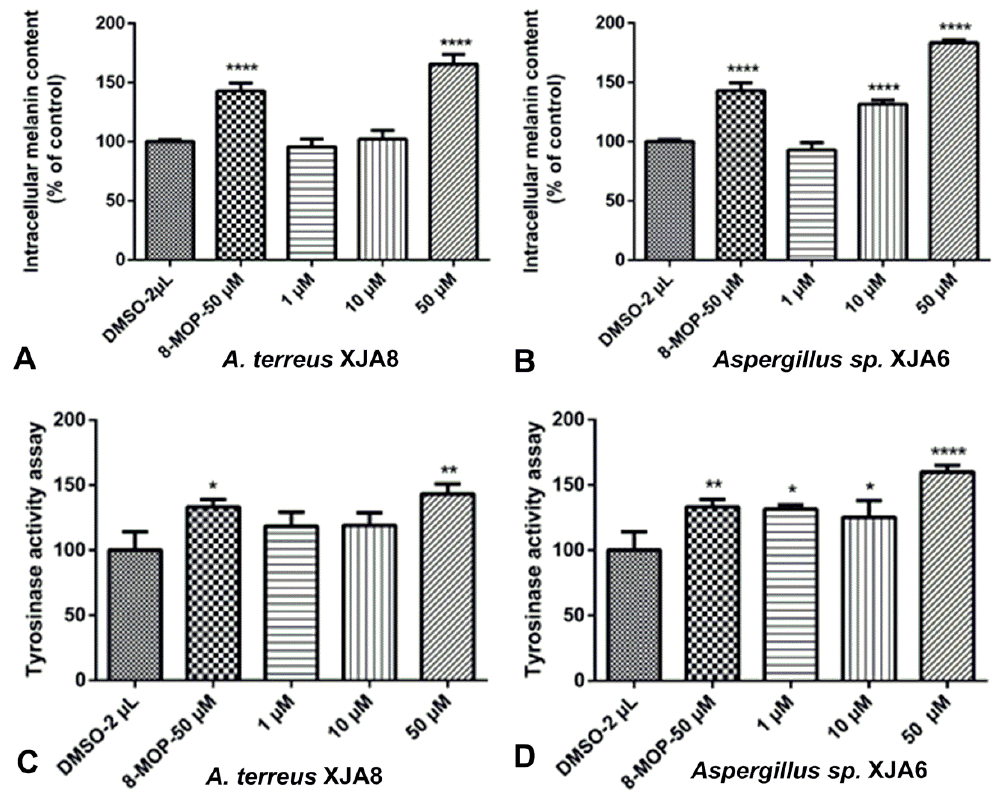
Figure 4. Stimulation of melanin content assay ( A , B ) and tyrosinase activity of B16 cells ( C , D ) by fungal strain crude extracts at di ff erent concentrations of Aspergillus sp. XJA6 and A. terreus XJA8. (All **** p values for melanin content and tyrosinase activity are ≤ 0.0001, compared with the DMSO-treated control. All * p -values for tyrosinase activity are < 0.05, while ** p -values for tyrosinase activity are < 0.01, compared with the DMSO-treated control).